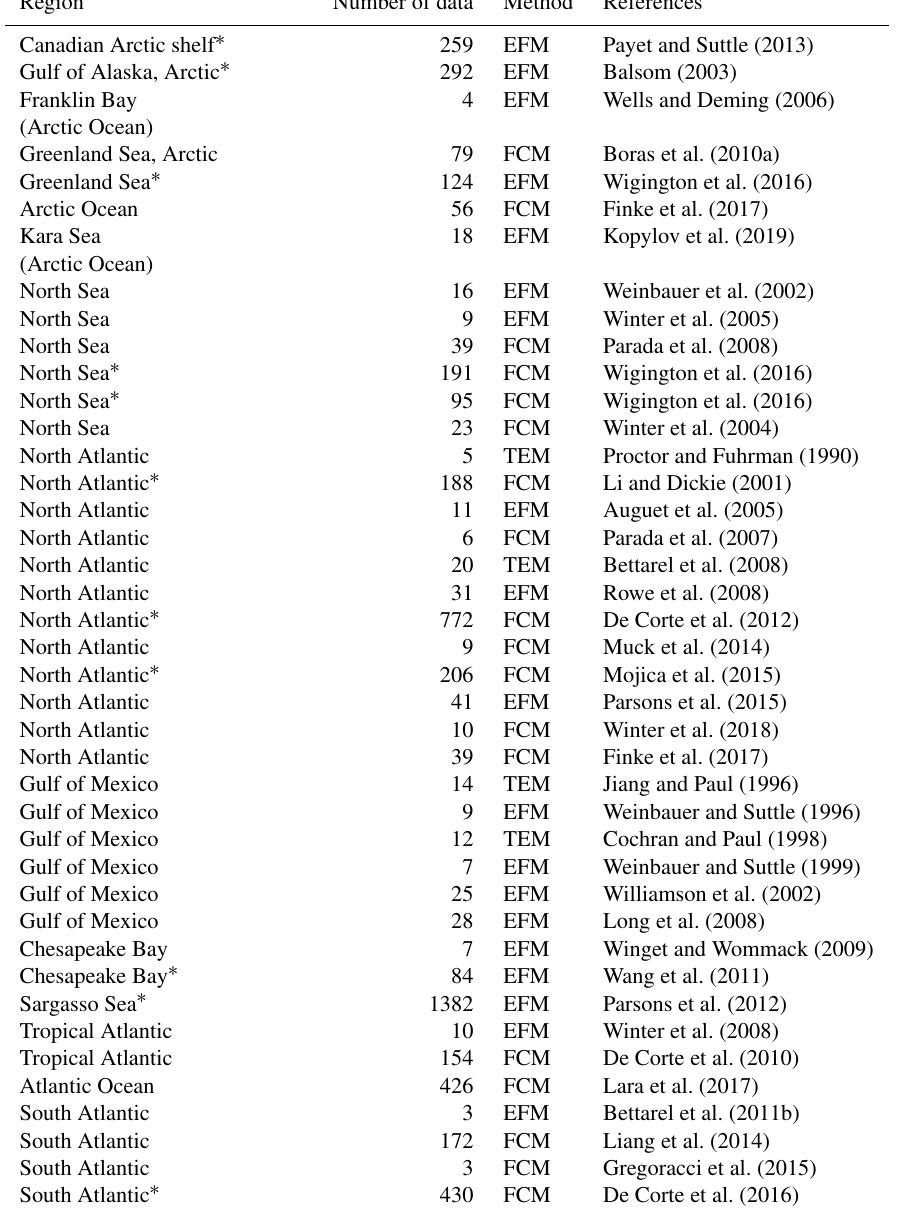
Table A1. Sources and methods of viral abundance data. EFM: counted by epifluorescence microscopes; FCM: counted by flow cytometer; TEM: counted by transmission election microscopy. Data marked by ∗ are those collected in a previous dataset (Wigington et al.,